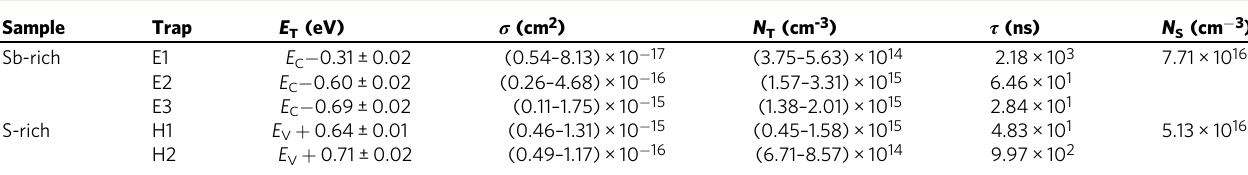
Table 1 Deep-level defect parameters (trap type, trap energy level ( E T ), capture cross section ( σ ), trap density ( N T ), carrier lifetime ( τ ), shallow donor concentration ( N S )) of Sb-rich and S-rich Sb 2 S 3 fi